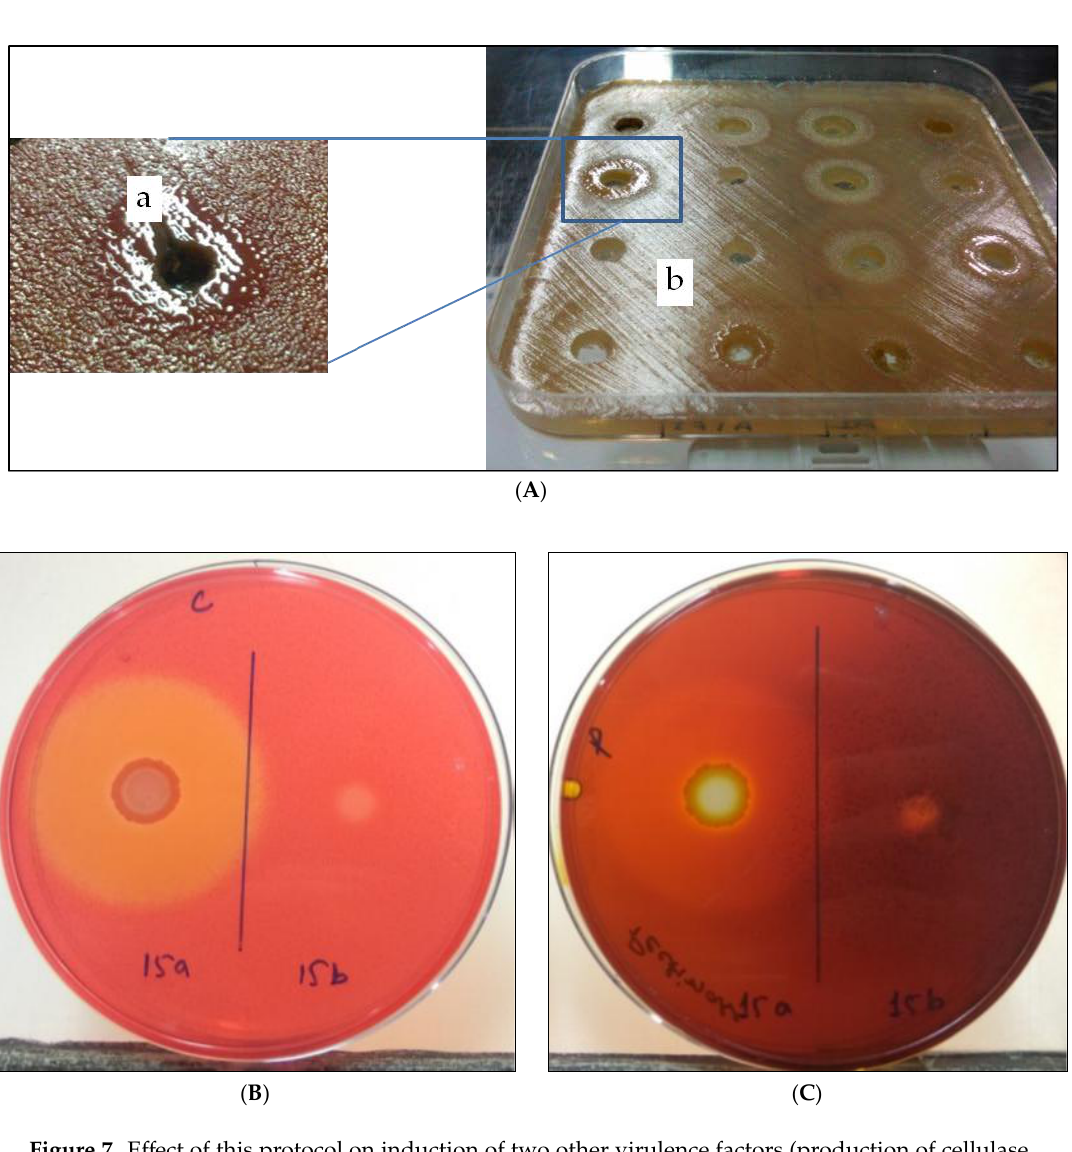
Figure 7. Effect of this protocol on induction of two other virulence factors (production of cellulase and pectinase). ( A ) Induction in appearance of fluidal colonies, ( B ) difference in cellulase production capabilities between induced and non-induced colonies (between zone ‘a’ and ‘b’), and ( C ) difference in pectinase production capabilities between induced and non-induced colonies.